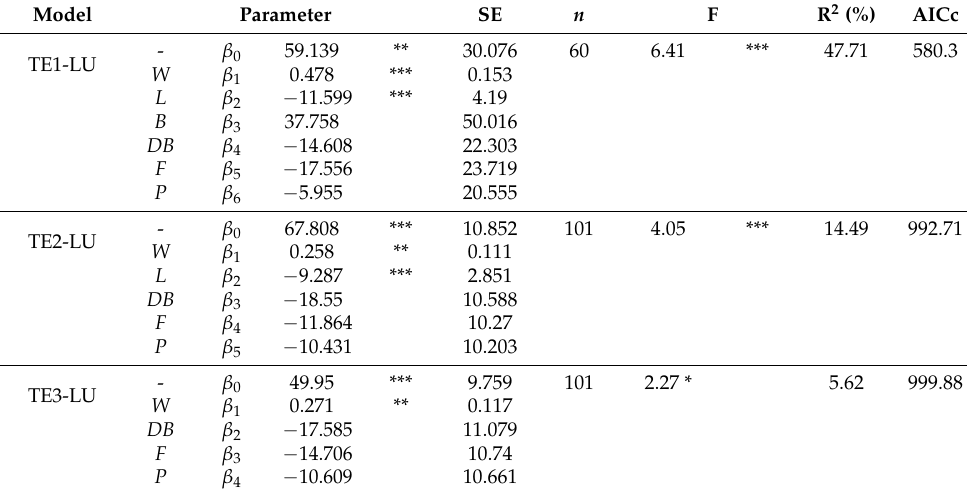
Table 5. Parameter estimates and goodness of fit statistics of the general mixed-effects models for estimating total CO 2 emissions for all land uses.